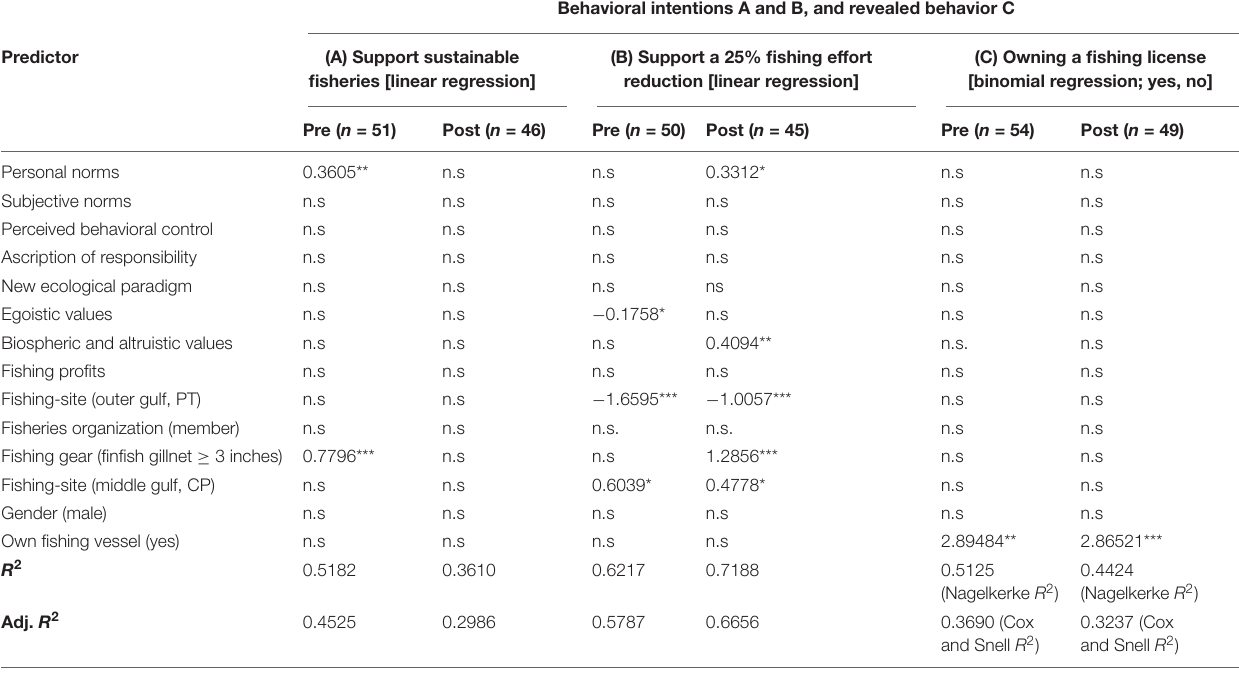
TABLE 3 | Results of regression analysis for the pre and post surveys samples.